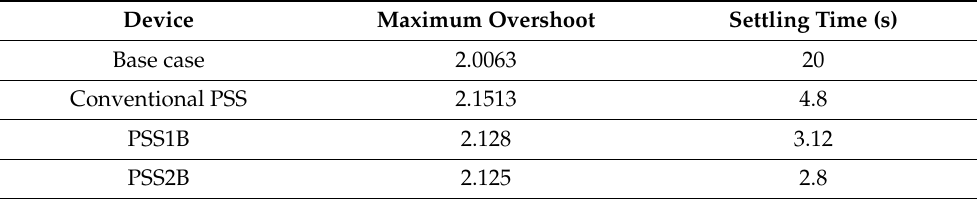
Table 20. Maximum overshoot and settling time of rotor angle at light loading.